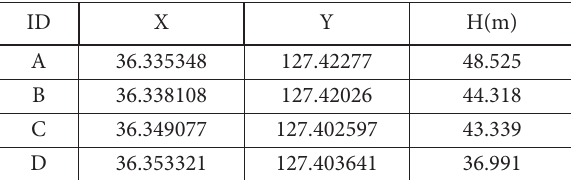
Table 4. Coordinates of the sampling points for NPS